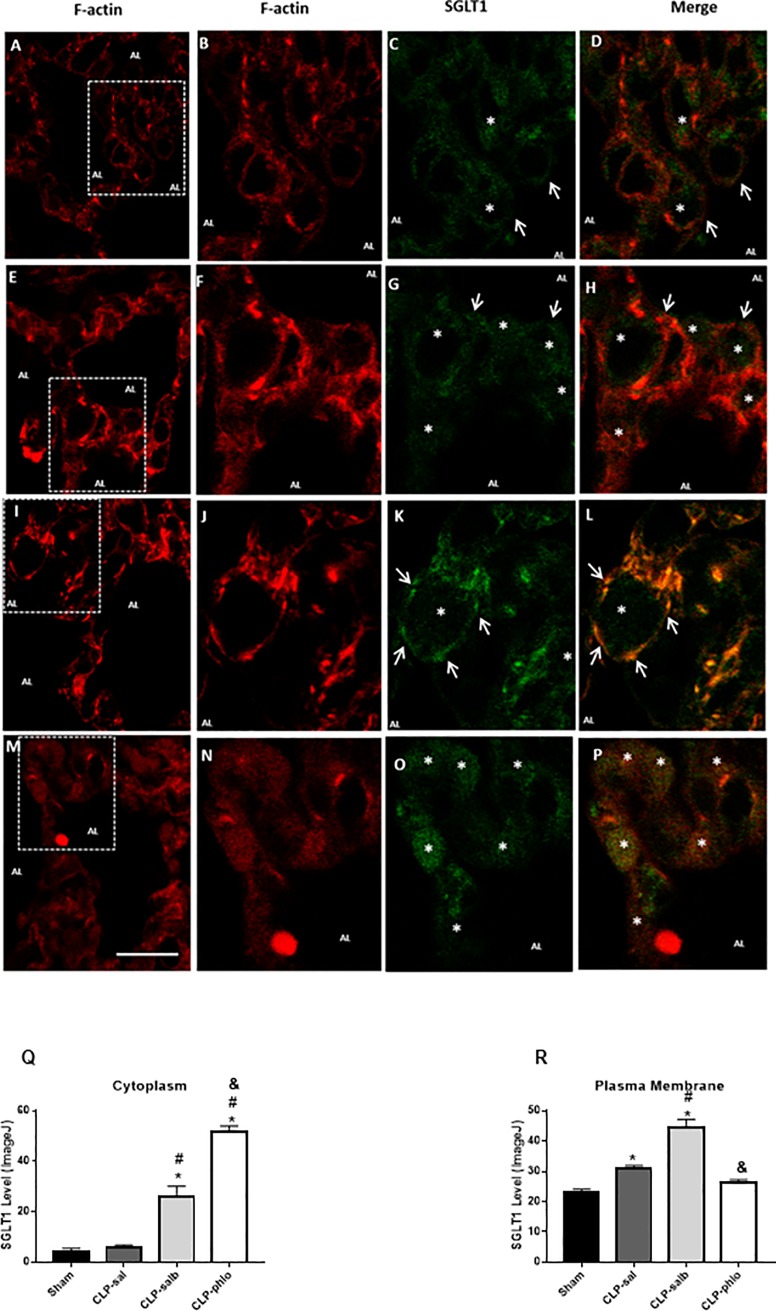
SGLT1 staining in lung tissues.Alveolar structures in lung from Sham (A to D), CLP saline (CLP-sal, E to H), CLP salbutamol (CLP-salb, I to L) and CLP phlorizin (CLP-phlo, M to P) treated rats. Sections (A, E, I and M) were immunostained with anti-F-actin antibody (red). White enclosed boxes showing an alveolar septum and alveolar lumen, taken with a greater resolution, are presented in the next sections: (B, F, J and N) F-Actin (red), (C, G, K and O) SGLT1 (green) and (D, H, L and P) merged photomicrographs for co-localization of SGLT1 and F-actin (yellow to orange). White arrows indicate the presence of SGLT1 in the luminal membrane. White asterisks indicate SGLT1 in cytoplasm. Description: (AL) alveolar lumen of the rat pulmonary section. Magnification, x600, scale bar, 10 μm. Section Q and R show the protein level in cytoplasm or plasma membrane, respectively. Images are representative of 4 animals in each group.